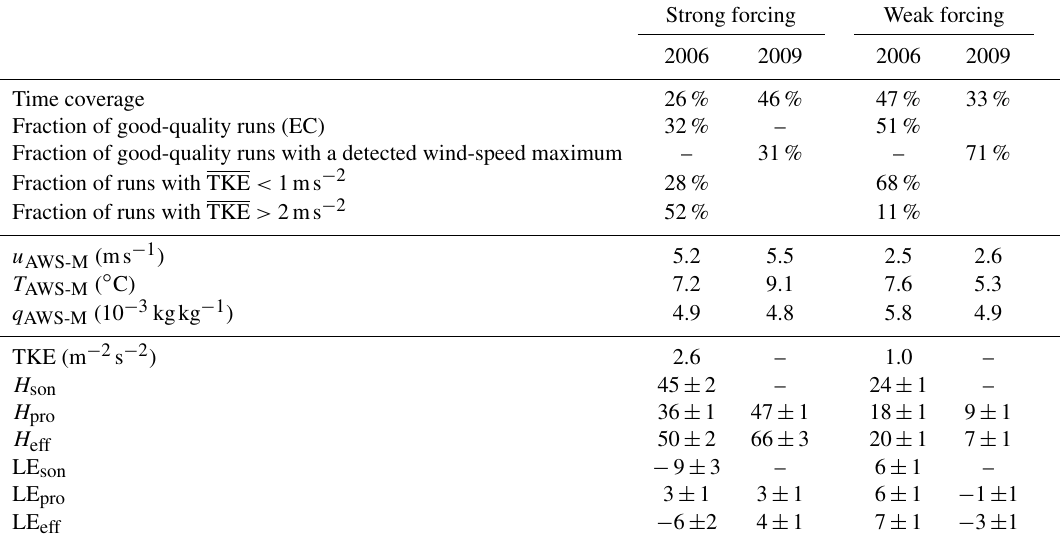
Table 2. Characteristics of the two field campaigns in terms of WP frequencies, meteorological data and turbulence characteristics: fraction of runs recorded under each group of WPs. Fraction of good-quality runs for the EC data in 2006 inside each group and fraction of runs inside each group during the 2009 campaign, for which a wind-speed maximum was observed with the profile mast. Mean meteorological variables recorded by the AWS-M, mean TKE in each weather group, fraction of run in SF and WF conditions for which TKE is > 2ms − 2 or < 1ms − 2 and mean turbulent fluxes obtained from the different methods.